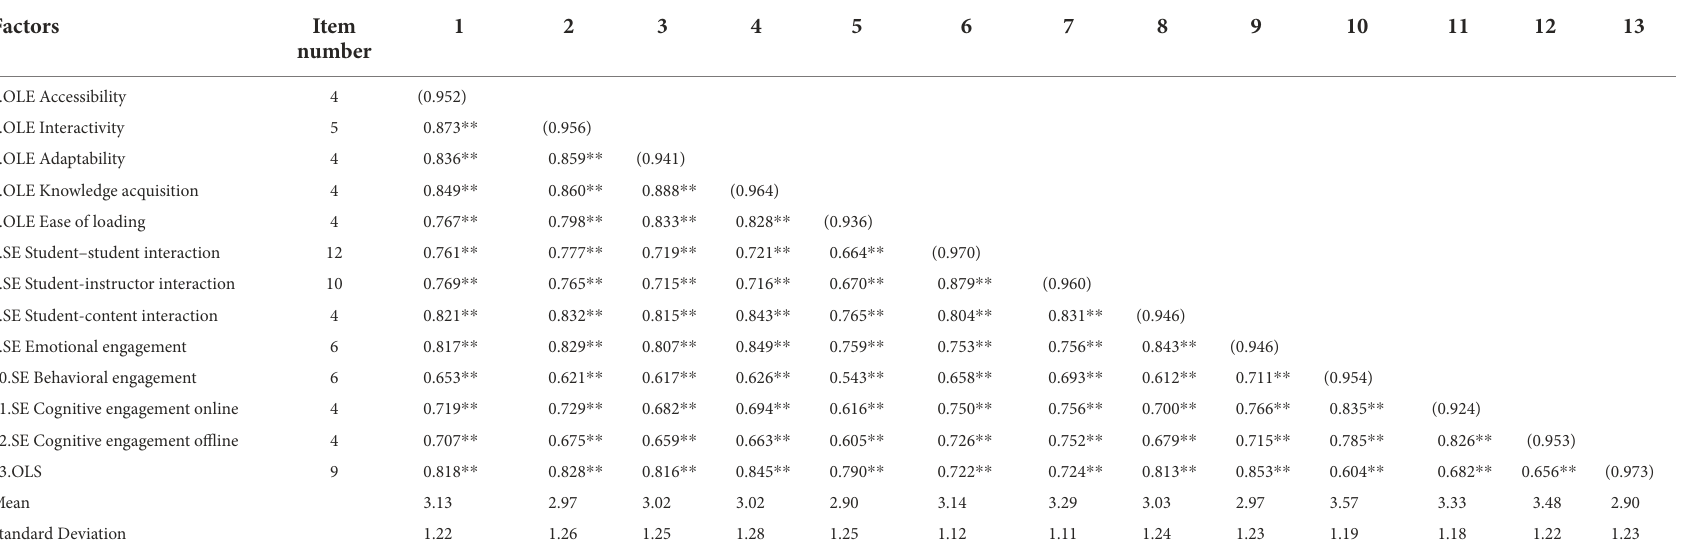
TABLE 5 Reliability, correlation matrix, and descriptive statistics.